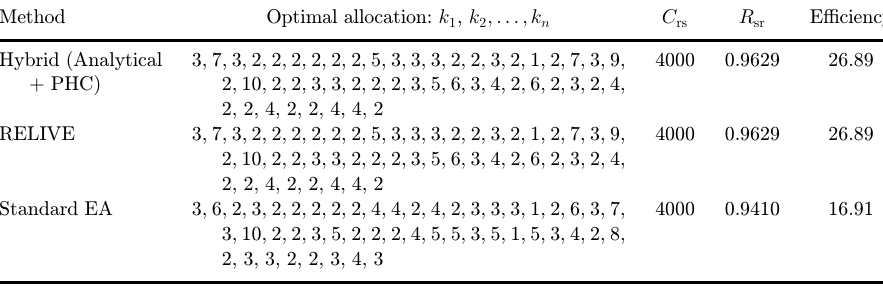
Table 2. The best solutions found by the considered methods: Experiment I, Problem 1.